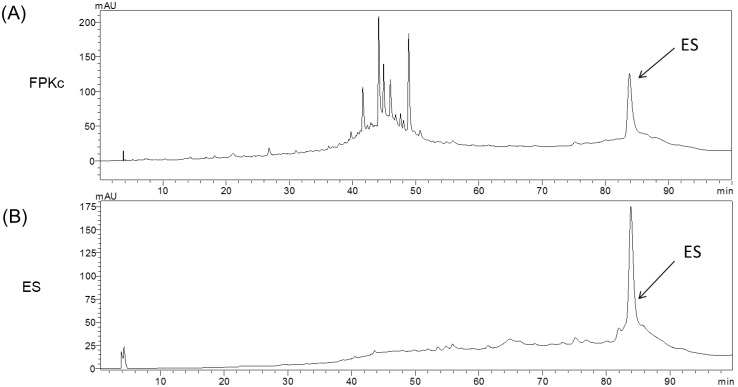
The HPLC chromatograms of FPKc (A), standard ergosterol (B).FPKc and ES standard were identified by HPLC-PDA at 254 nm as described in the experimental section.